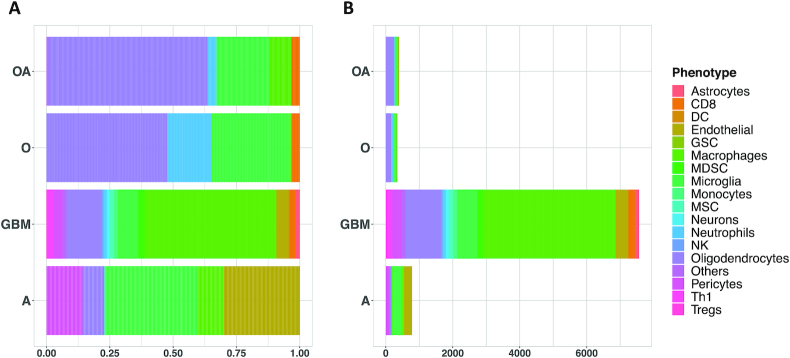
Tumor microenvironment cell type classification in glioma. The bar plots show the relative percentage (A) and the number of cells (B) of each cell type identified in the microenvironment of the main histological subtypes of glioma. DC: dendritic cell; GSC: glioma stem cell; MDSC: myeloid-derived suppressor cell; MSC: mesechymal stem cell; NK: natural kiler cell; Treg: regulatory T cell.